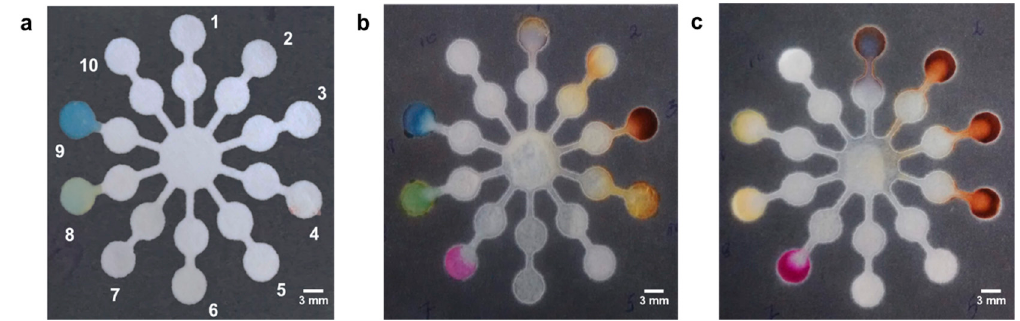
Figure 5. Multiplex paper microfluidic setup for testing several analytes. ( a ) After adding reagents; ( b ) after adding milk; ( c ) after adding lemonade. 1: ascorbic acid; 2: glucose; 3: lactose; 4: heated lactose; 5: nitrite; 6: guaiacol; 7: citric acid; 8: bromocresol green (7.53); 9: bromophenol blue (pH = 7.12); 10: control. (Scale bar: 3 mm).